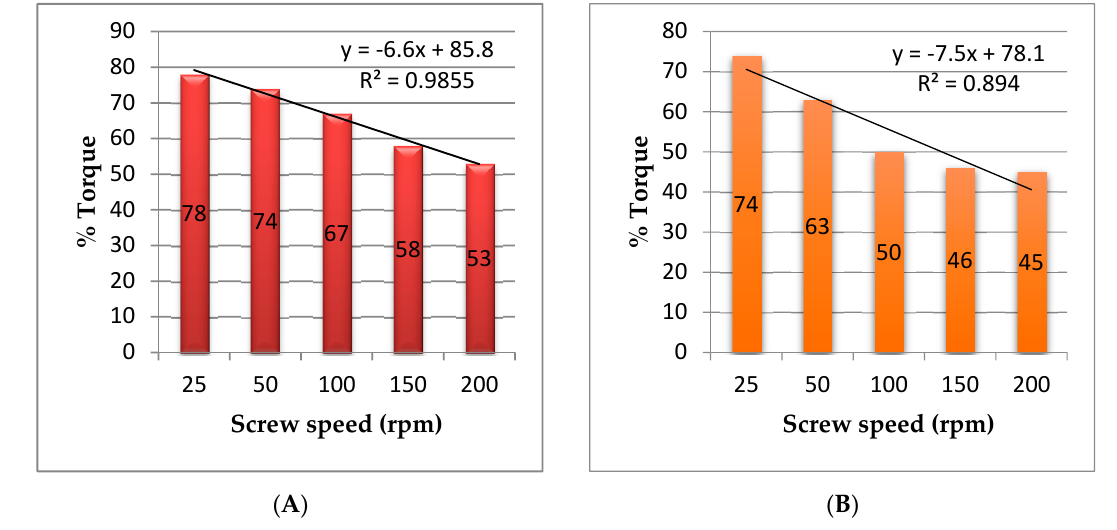
Figure 2. Extruder torque readings observed during processing of novel SSB ® 55 Pharma grade Shellac with ( A ) temperature profile 1, and ( B ) temperature profile 2.